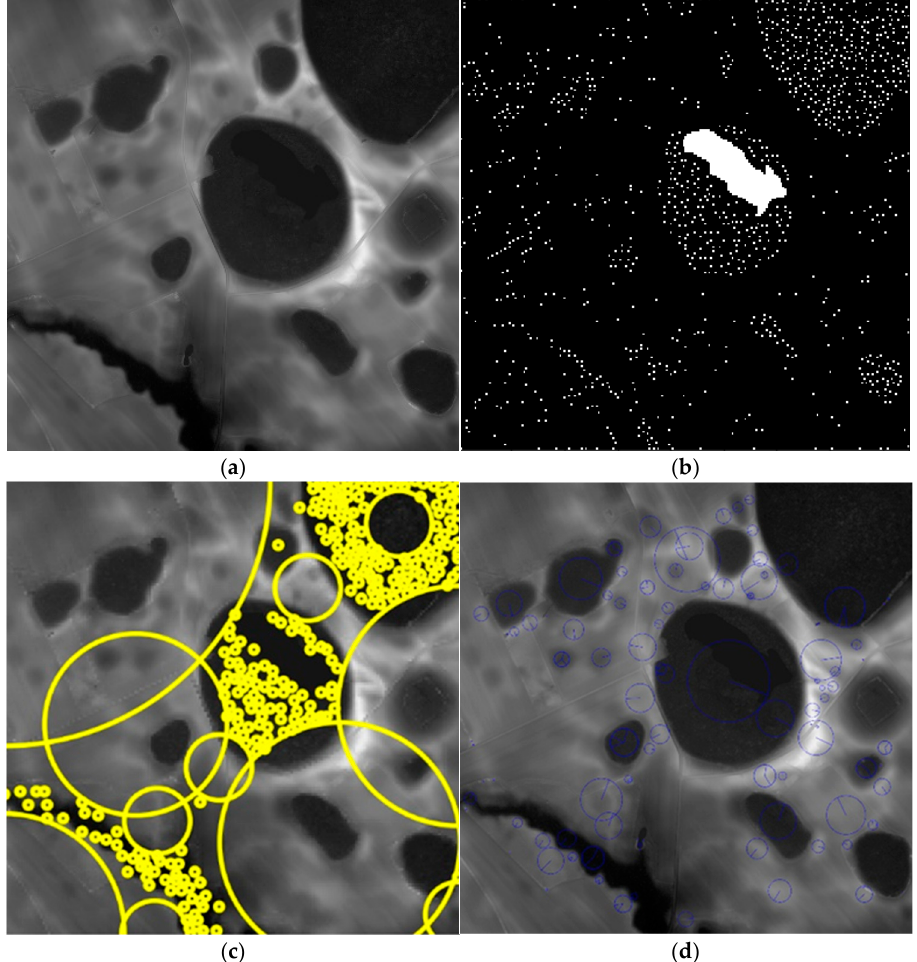
Figure 3. Traditional computer vision algorithms tested for Carolina Bay detection. ( a ) Input DEM. ( b ) Local minima detector (each white point is a local minima). ( c ) Laplacian of Gaussians blob detector (detected blobs and their radii are shown in yellow). ( d ) Scale invariant feature transform (SIFT; keypoints and their radii are shown in blue).